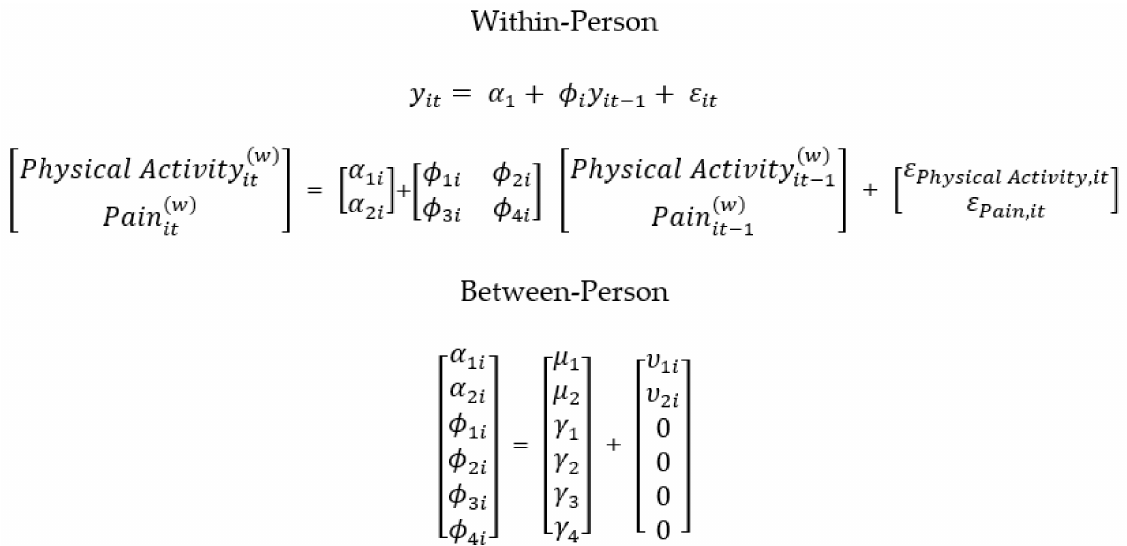
Figure 4. VAR(1) Model: Within-Person and Between-Person Equations.